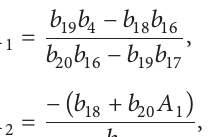
Figure 2: Generated energy for the simple and clamped supports according to the variations of piezoelectric plate radius ( 𝑅 2 = 20 mm) (Sections 2.1 and